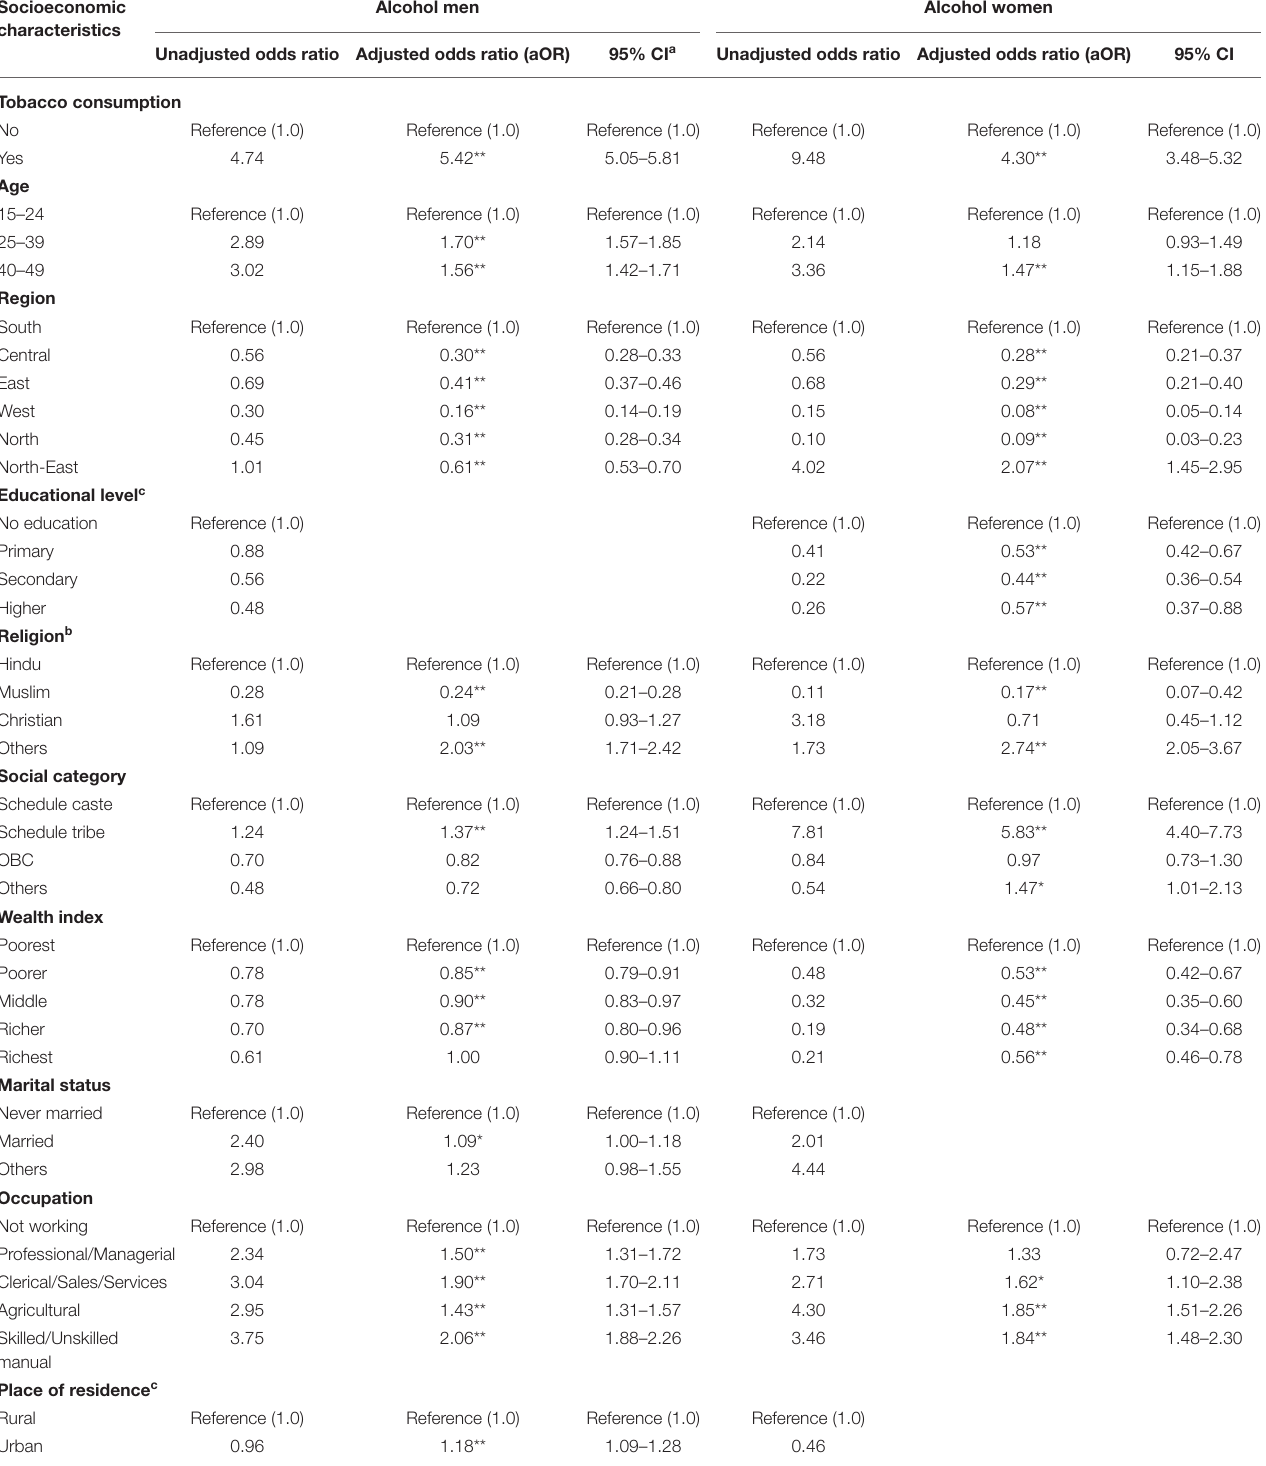
TABLE 3 | Socioeconomic and demographic characteristics of alcohol consumption, India, NFHS-4. Socioeconomic